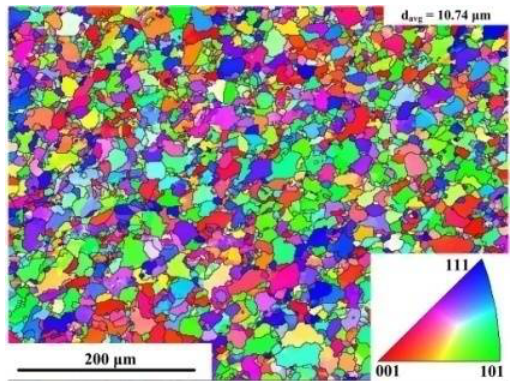
Figure 2. EBSD map of non-deformed